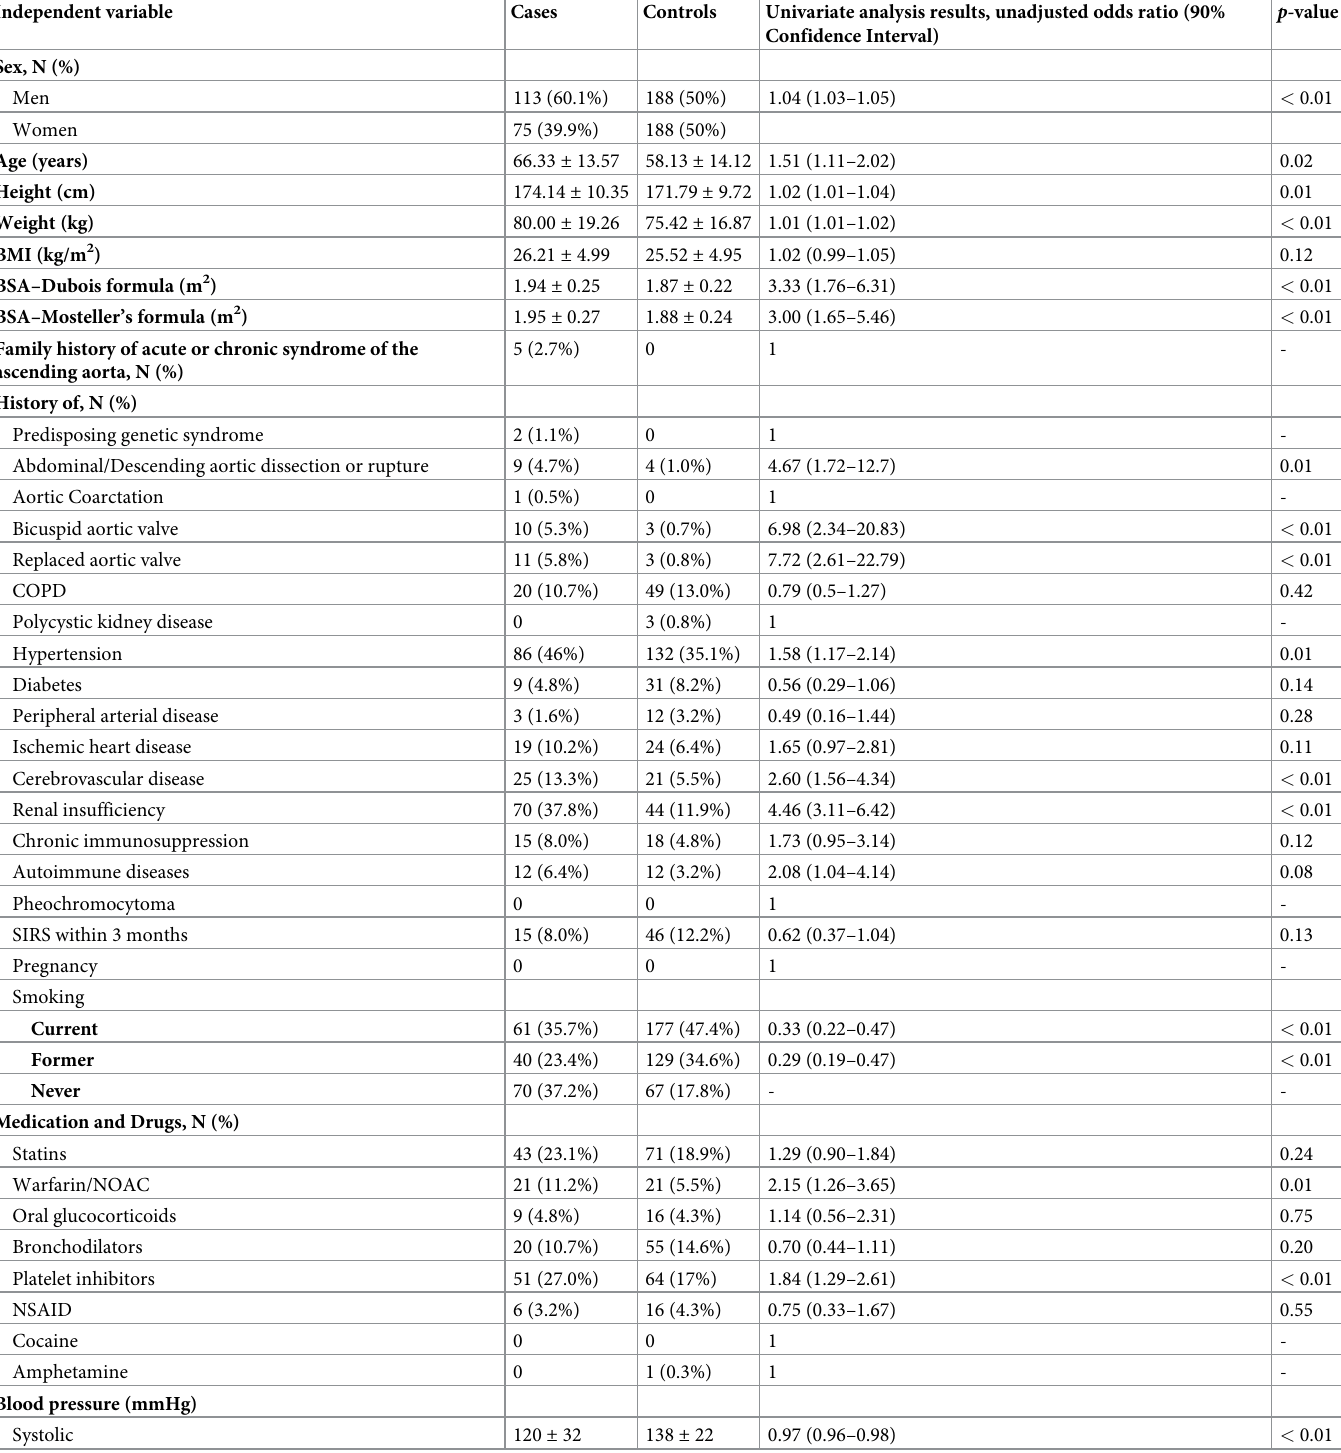
Table 1. Descriptive statistics of independent variables gathered through medical record review, and results of univariate logistic regression analysis, where the presence of acute or chronic aortic syndrome of the ascending aorta is the dependent variable. Continuous variables are presented with mean ± standard deviation, categorical variables with numbers and frequency. “- “= no results due to no/low